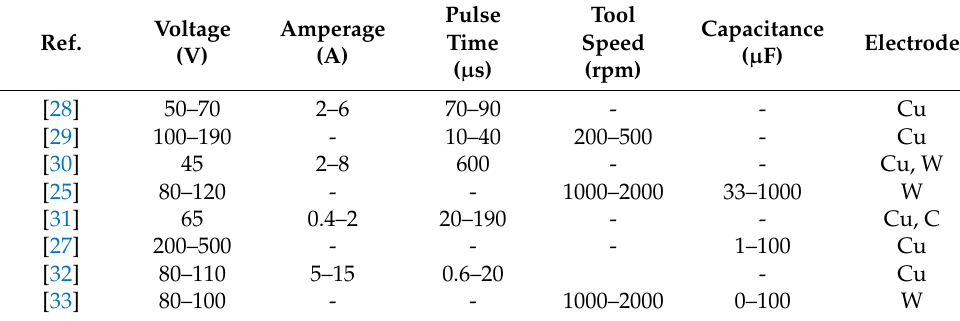
Table 1. Machining parameters used in the consulted bibliography.